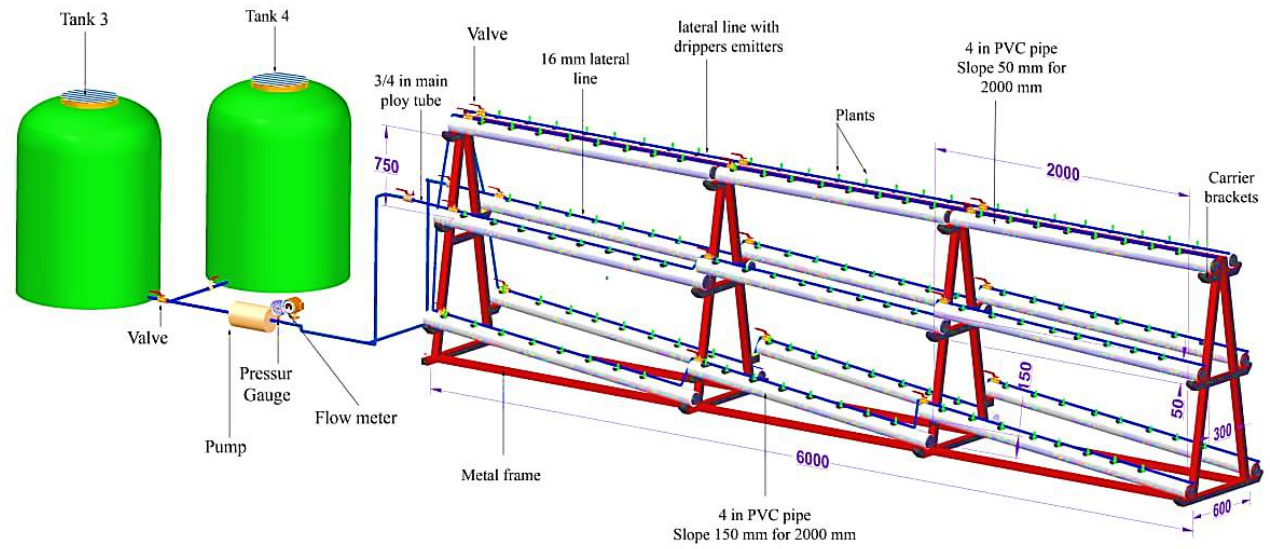
Figure A2. Engineering drawing and set-up showing the experimental hydroponic farming system without magnetic device.